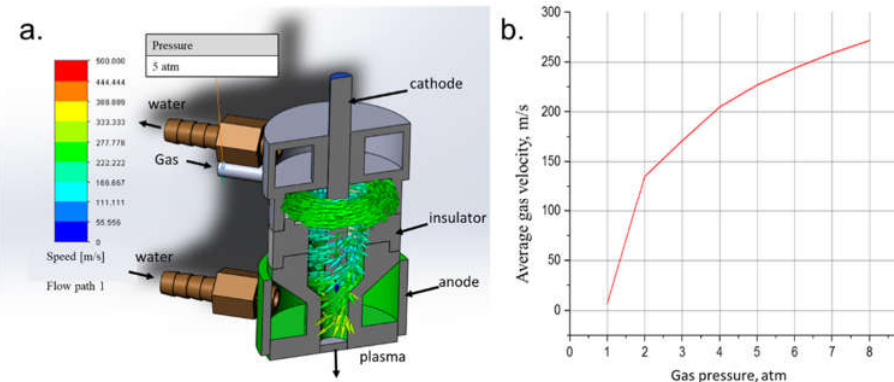
Figure 3. Results of aerodynamic modeling of transporting gas: ( a ) Gradient of velocity distribution; ( b ) Dependence of average gas velocity on operating gas pressure.